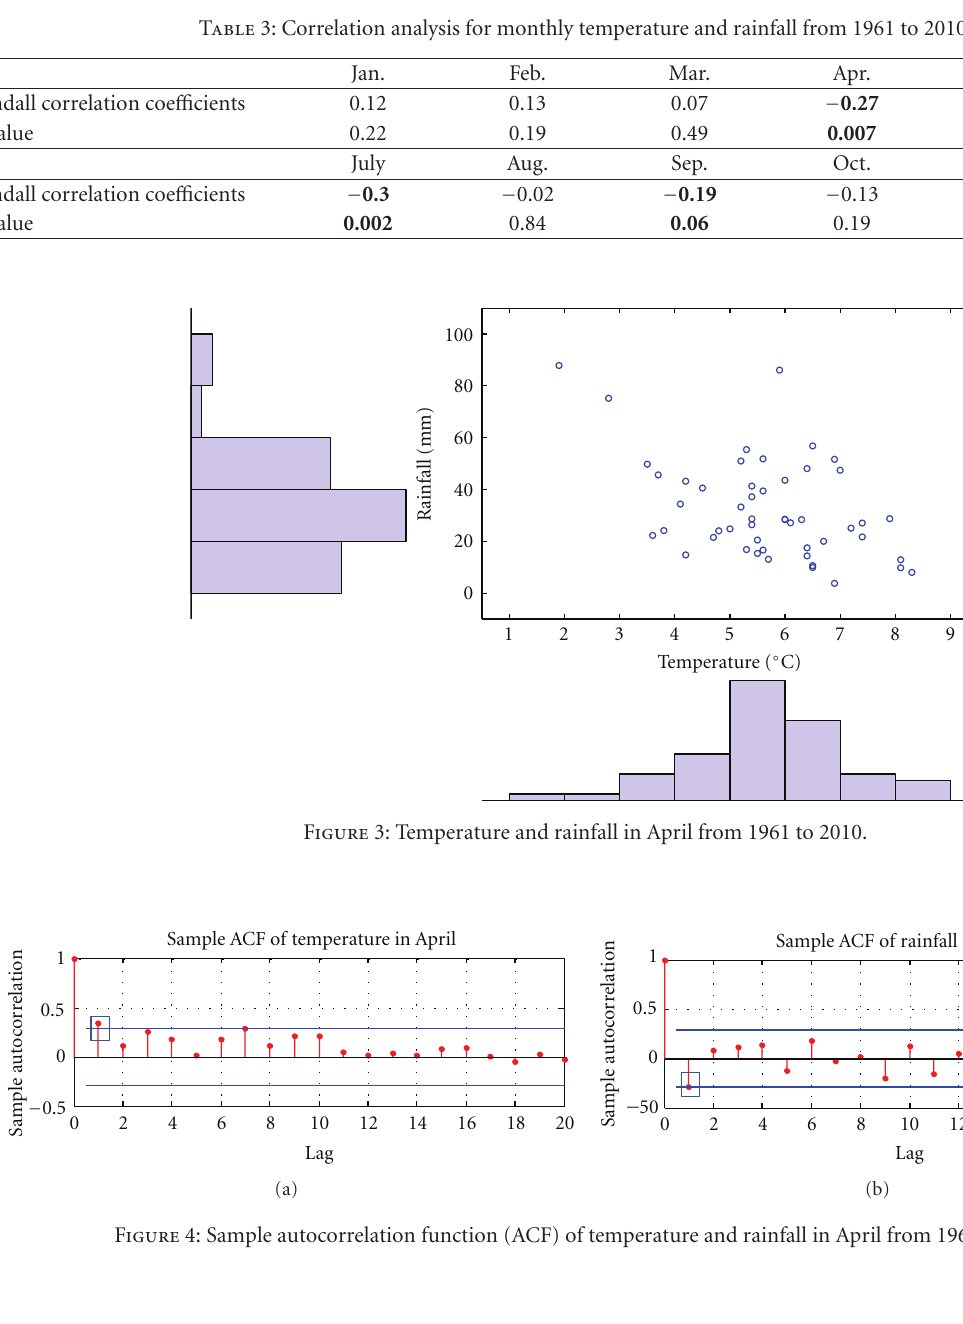
Sample ACF of temperature residuals in April